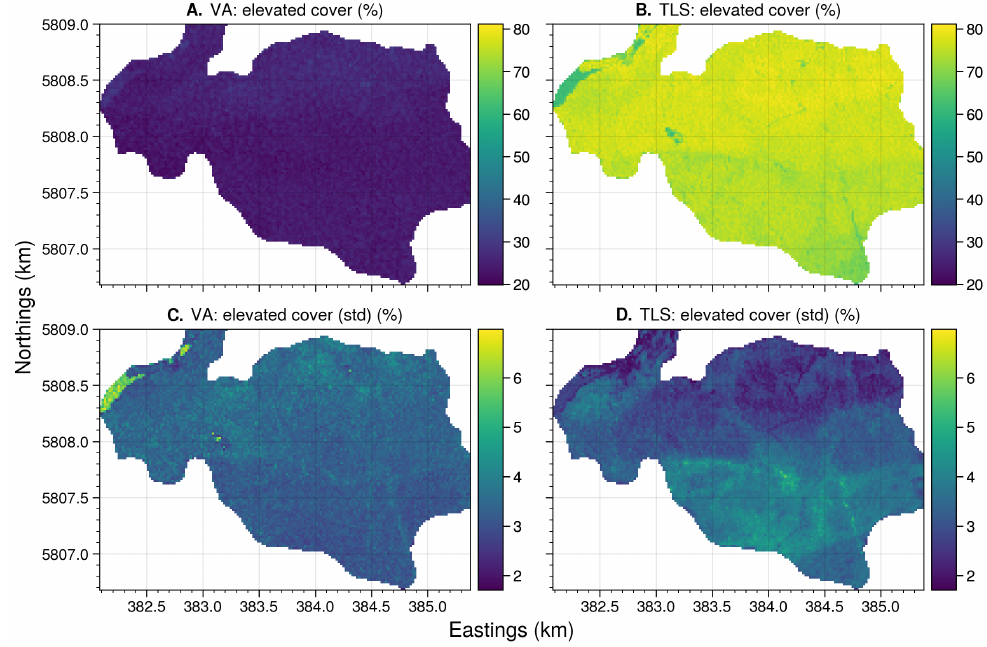
Figure A14. The mean and standard deviation of landscape-level predictions for elevated fuel cover using visual assessments ( A , C ) and TLS ( B , D ) at Three